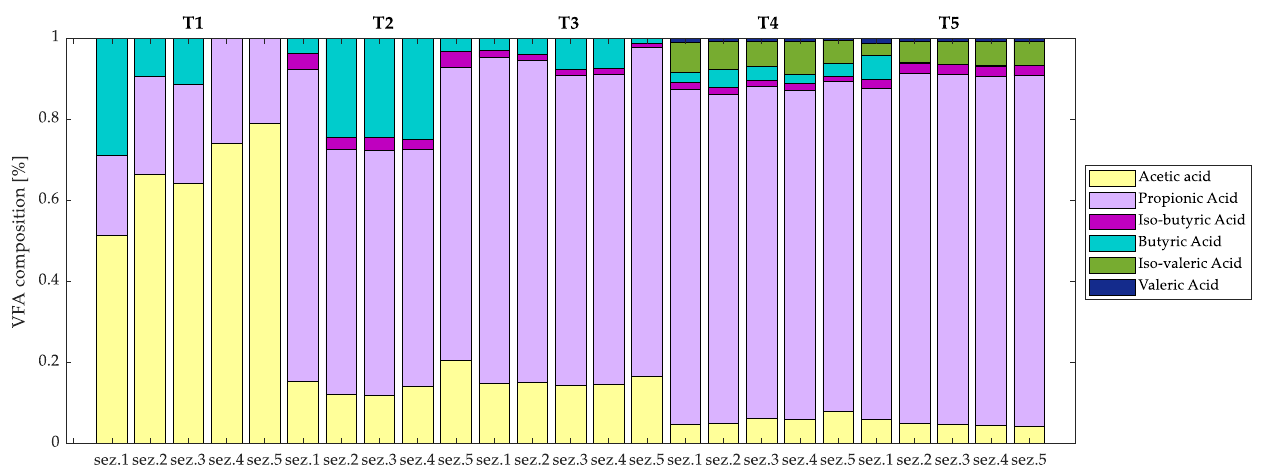
Figure 3. Composition of total VFAs at sections sez.1-sez.5 in each sampling campaign.